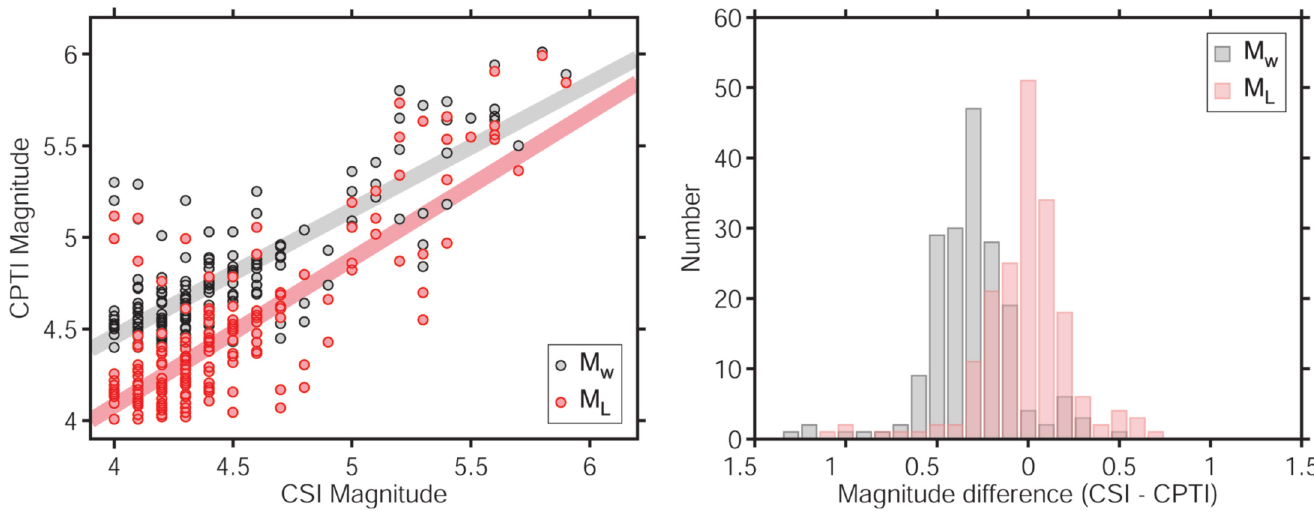
≥ 4.0. The black circles show M L calculated from M using the linear regression equation (1). (Right) The histograms show how the L w